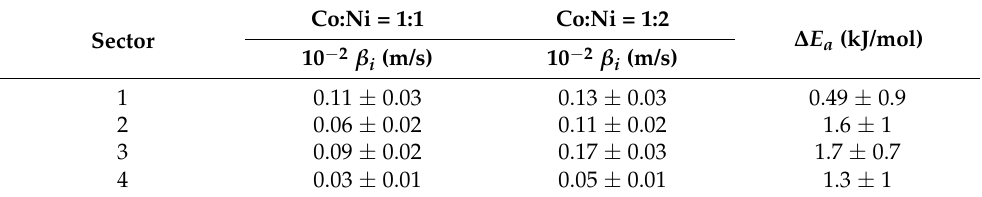
Table 2. Kinetic coefficients of steps on the sectors of growth hillocks on the (110)